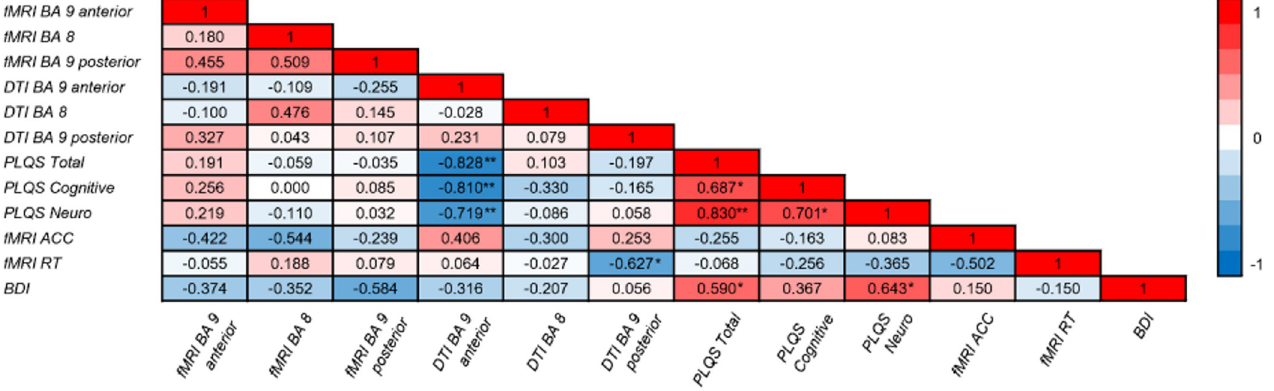
Fig 5. Correlation matrix of the relationship among fMRI, DTI, and clinical variables. Brain regions correspond to the regions of interest revealed by fMRI between-groups contrasts that were located in white matter. FMRI beta values and DTI axial diffusivity measures were correlated with clinical variables. Notably, DTI measures of the BA 9 anterior region negatively correlated with PLQS scores (i.e., higher axial diffusivity was associated with fewer symptoms). PLQS = post-Lyme questionnaire of symptoms, fMRI ACC = accuracy on the fMRI task, fMRI RT = response times on the fMRI task, BDI = Beck Depression Inventory; � = p � .05; �� = p � .01